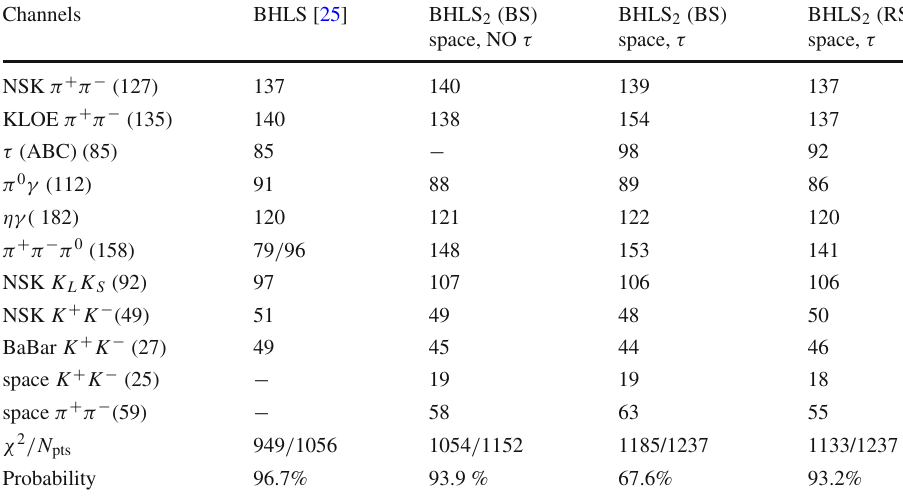
Table 3 Global fit properties of BHLS and of the BS and RS variants of BHLS 2 : χ 2